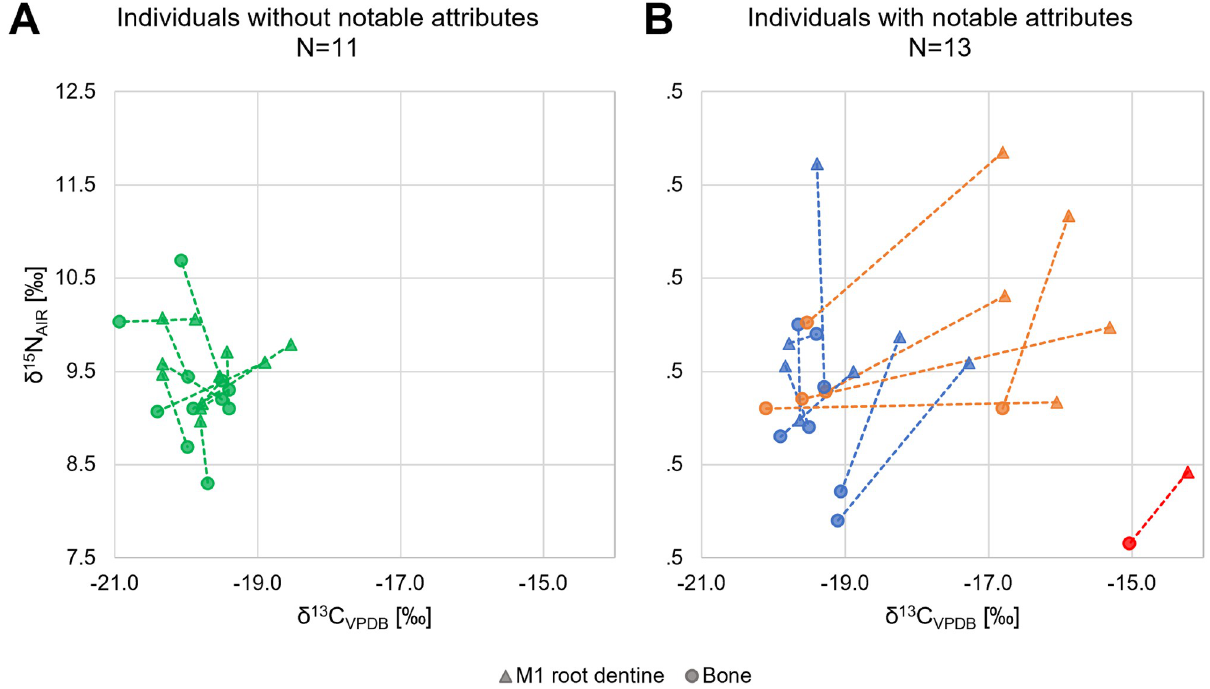
Fig 7. Differences between bulk dentine and bone collagen. (A) Differences between bulk dentine and bone collagen of individuals without notable attributes (N = 11, illustrated in green), and (B) individuals with notable attributes (outliers in enamel 87 Sr/ 86 Sr illustrated in blue, outliers in bone collagen δ 13 C and/or δ 15 N illustrated in red, or the presence of ACD illustrated in orange) (illustration: Excel).